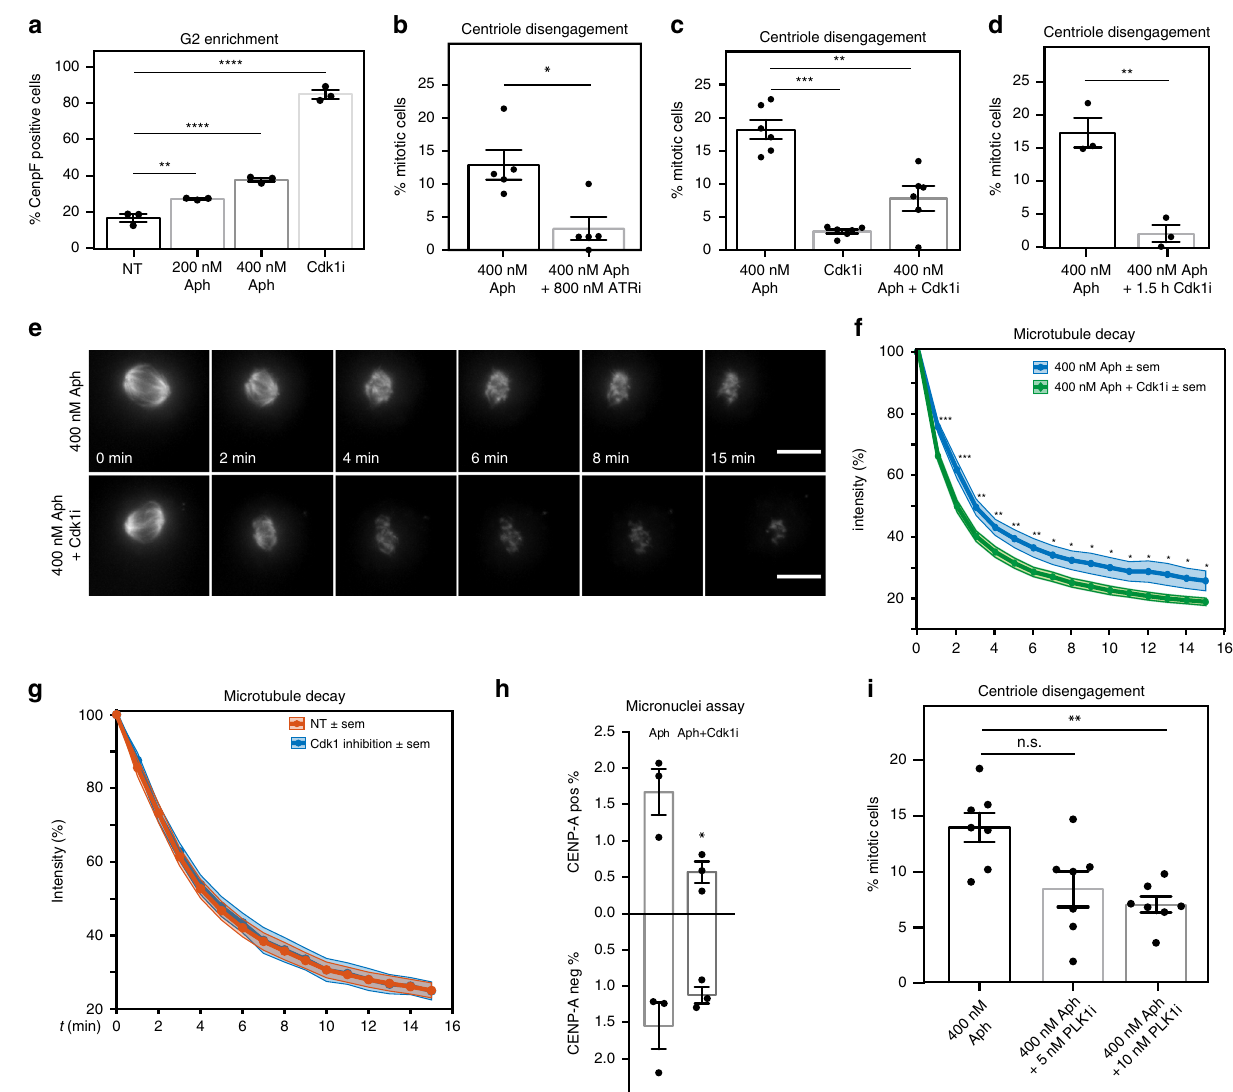
Fig. 4 Replication stress phenotypes depend on Cdk1-, Plk1- and ATR. a Mean percentages of CENP-F positive RPE1 cells; N = 3 examining NT = 1398, 200 nM Aph = 1549, 400 nM Aph = 1632 and Cdk1i = 865 interphase cells; p < 0.0001 in a one-way Anova (NT vs. 200 nM Aph p = 0.005; NT vs. 400 nM Aph p < 0.0001; NT vs. Cdk1 inhibition p < 0.0001). b Mean percentages of disengaged RPE1 centrin1-GFP cells; N = 5 examining Aph = 210 and Aph/ATR = 221 mitoses; p = 0.0275 in paired t -test. c Mean percentages of disengaged RPE1 centrin1-GFP cells; N = 6 examining Aph = 369, Cdk1i = 440 and Aph/Cdk1i = 457 mitoses; p < 0.0001 in a one-way Anova (400 nM Aph vs. Cdk1 inhibition p = 0.0005 and 400 nM Aph vs. 400 nM Aph + Cdk1 inhibition p = 0.003). d Mean percentages of disengaged RPE1 centrin1-GFP cells; N = 3 examining Aph = 159 and Aph/Cdk1i = 208 mitoses; p = 0.004 in unpaired t -test. e Representative time-lapse images of metaphasic RPE centrin1-GFP cells stained with SiR-tubulin and treated with a 200 nM nocodazole pulse at t = 0 after indicated treatments; scale bars = 10 μ m. f Quanti fi cation of the spindle signal as in Fig. 2d; N = 20 for Aph and 23 cells for Aph/Cdk1i; * p < 0.05; ** p < 0.01; *** p < 0.001 in a repeated measurement Anova test. g Quanti fi cation of the spindle signal as in Fig. 2d; N = 31 for Cdk1i and 34 for NT. h Mean percentage of RPE cells containing CENP-A-negative and positive micronuclei. N = 3 examining Aph = 2421 and Aph/Cdk1i = 1793 interphase cells p = 0.0339 in unpaired t -test. i Mean percentages of disengaged RPE1 centrin1-GFP cells; N = 7 examining Aph = 321, Aph/5 nM Plk1i = 336 and Aph/ 10nMPlk1i = 357 mitoses; p = 0.0377 in a one-way Anova (400 nM Aph vs. 5 nM Plk1 inhibition p = 0.1787 and 400 nM Aph vs. 400 nM Aph + 10 nM PLK1 inhibition p = 0.0091). Error bars indicate sem. Source data are provided as a Source Data fi